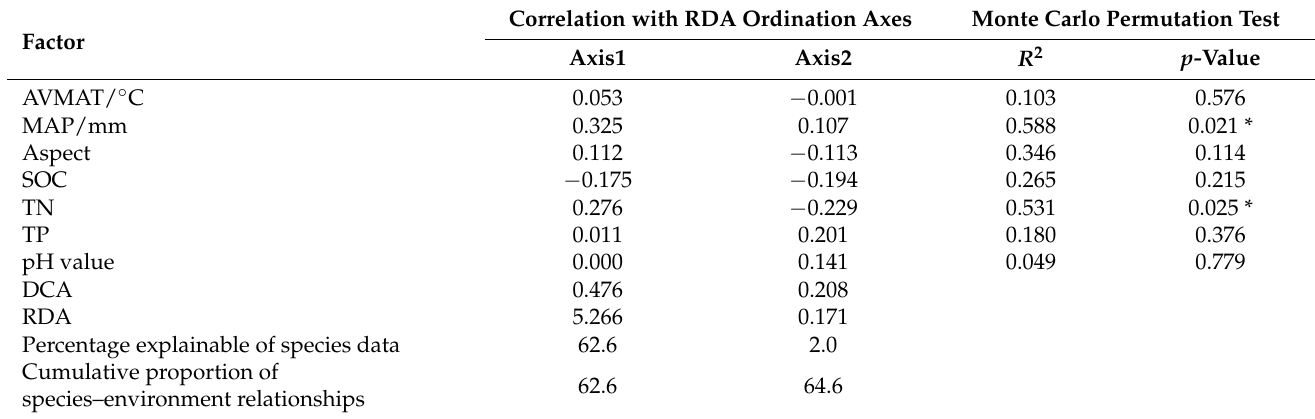
Table 3. Results obtained through the Redundancy Analysis ordination and the Monte Carlo permutation